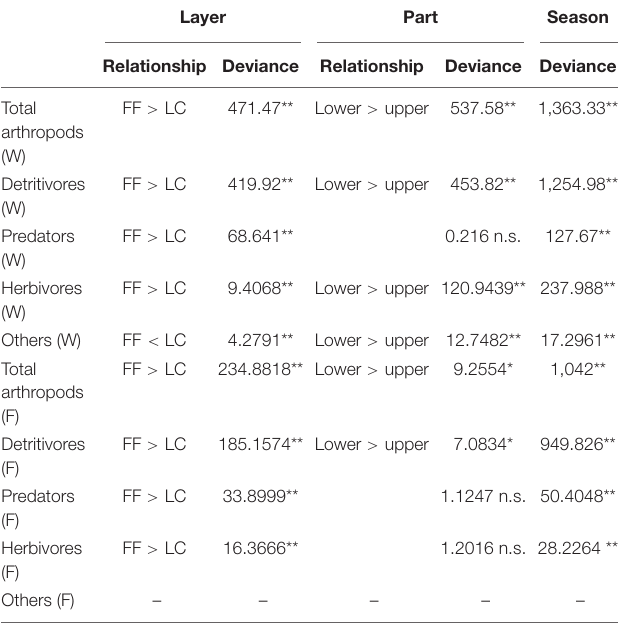
TABLE 2 | Summary of the results of the generalized linear mixed models (GLMMs) that incorporated the effects of trap height (Layer), trap parts (Part), and seasons (Season) on the abundance of feeding groups collected by trunk-sticky traps (a total of 80 samples) in a Japanese cedar ( Cryptomeria japonica )